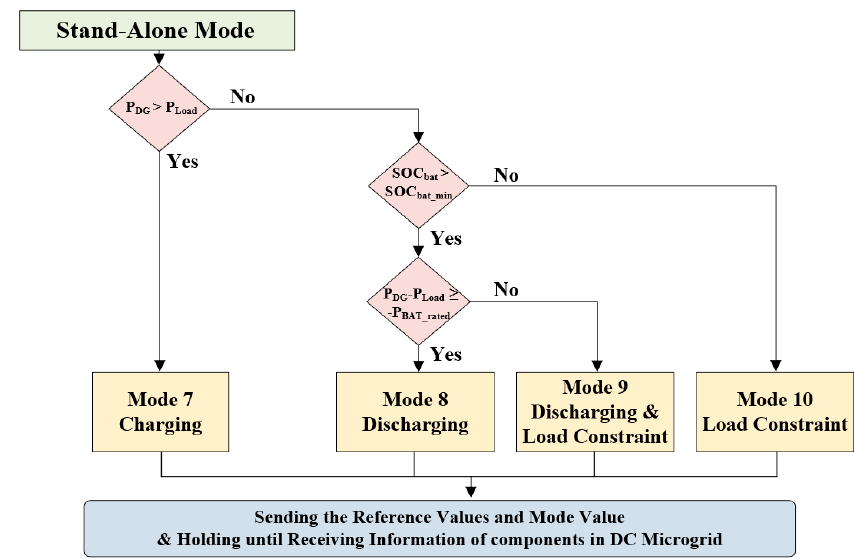
Figure 6. Flowchart of proposed EMS for operation method in stand-alone mode.